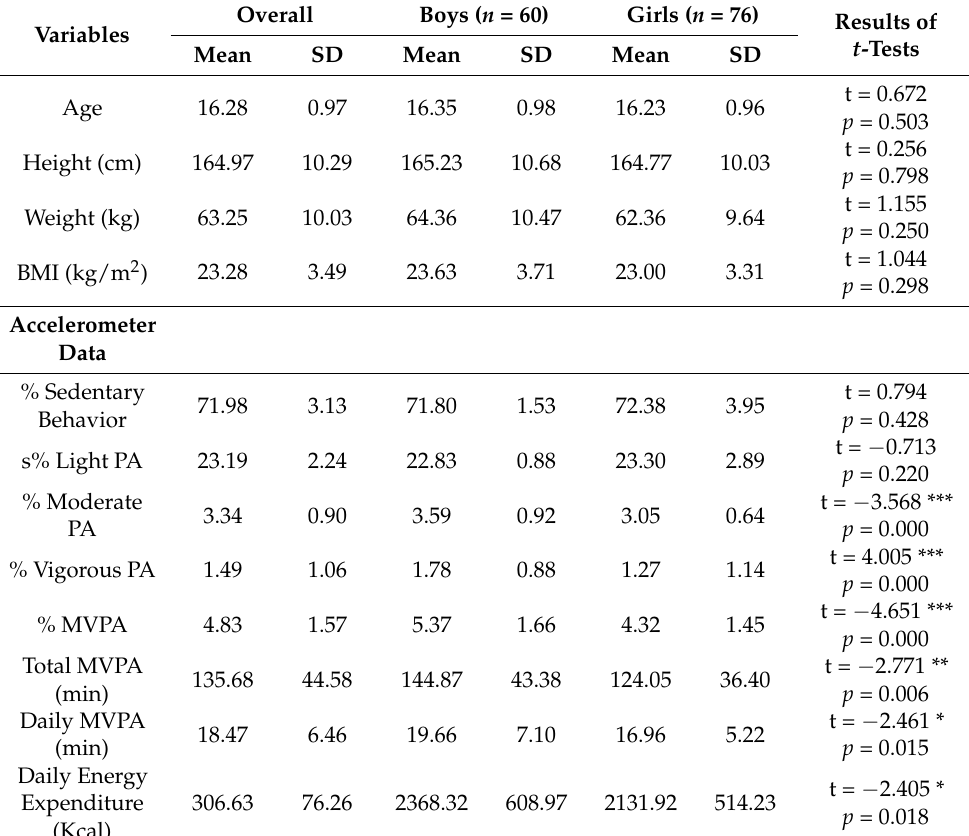
Table 1. Body-related and physical activity data of the